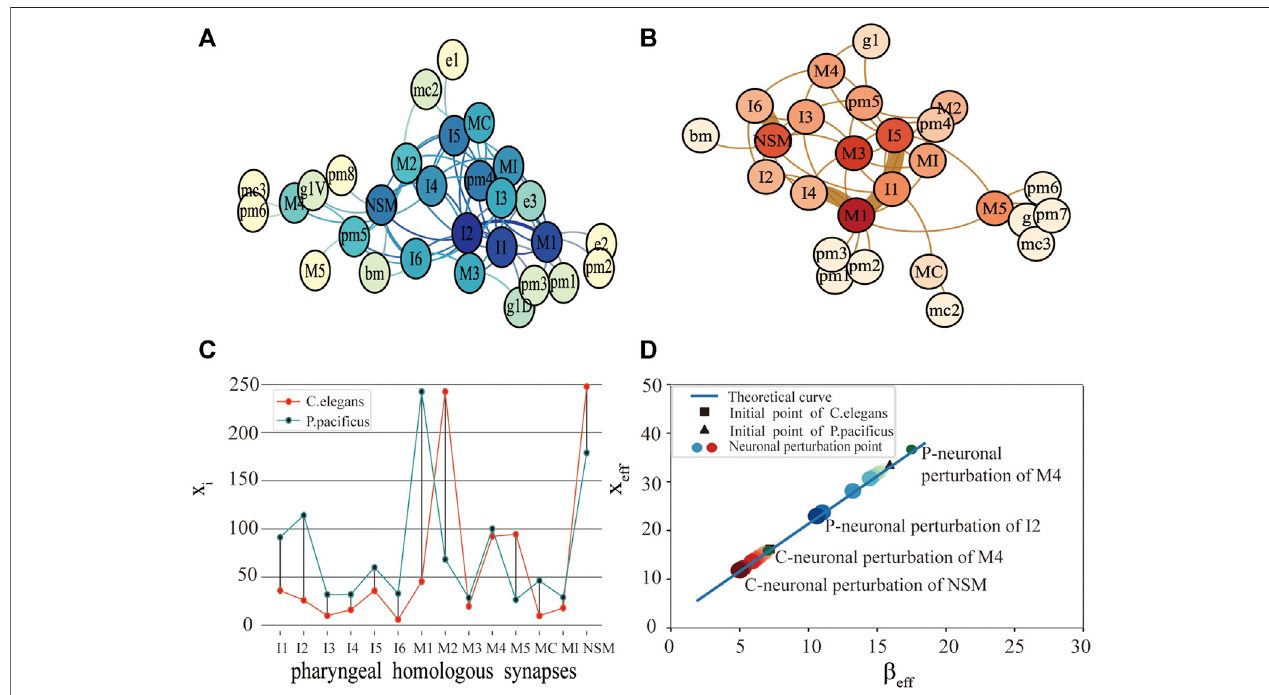
FIGURE1| Comparisonoffunctionandstructureofsynapticconnectivityin C.elegans and P.paci fi cus . (A) Neuronnetworkfor P.paci fi cus . (B) Neuronnetworkfor C.elegans . (C) Activity of 14 homologous synapses between C.elegans and P.paci fi cus . (D) System performance of C.elegans and P.paci fi cus while the neurons are disturbed.Theredcirclesrepresent thesystem resilienceof C.elegans whilethehomologoussynapses aredisturbed. Theblue circlesrepresentthesystemresilienceof P.paci fi cus . The darker the color, the greater the effect of the neuronal perturbation.